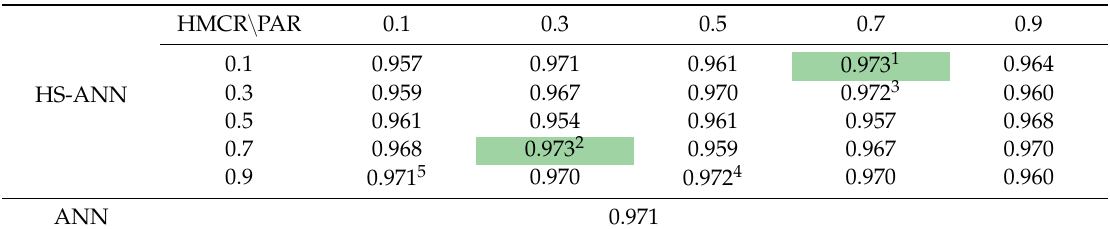
Table 4. Maximum values of correlation